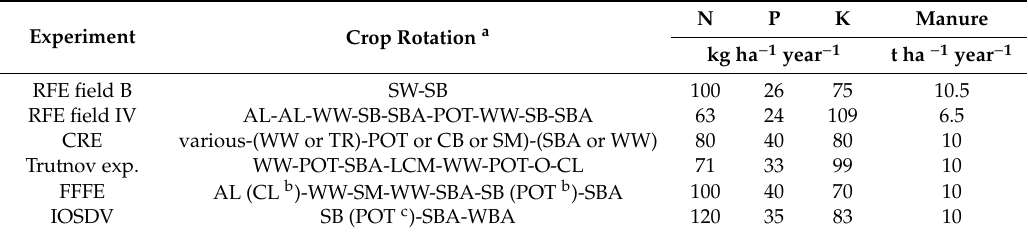
Table 2. Crop rotations and fertilization in the long-term field